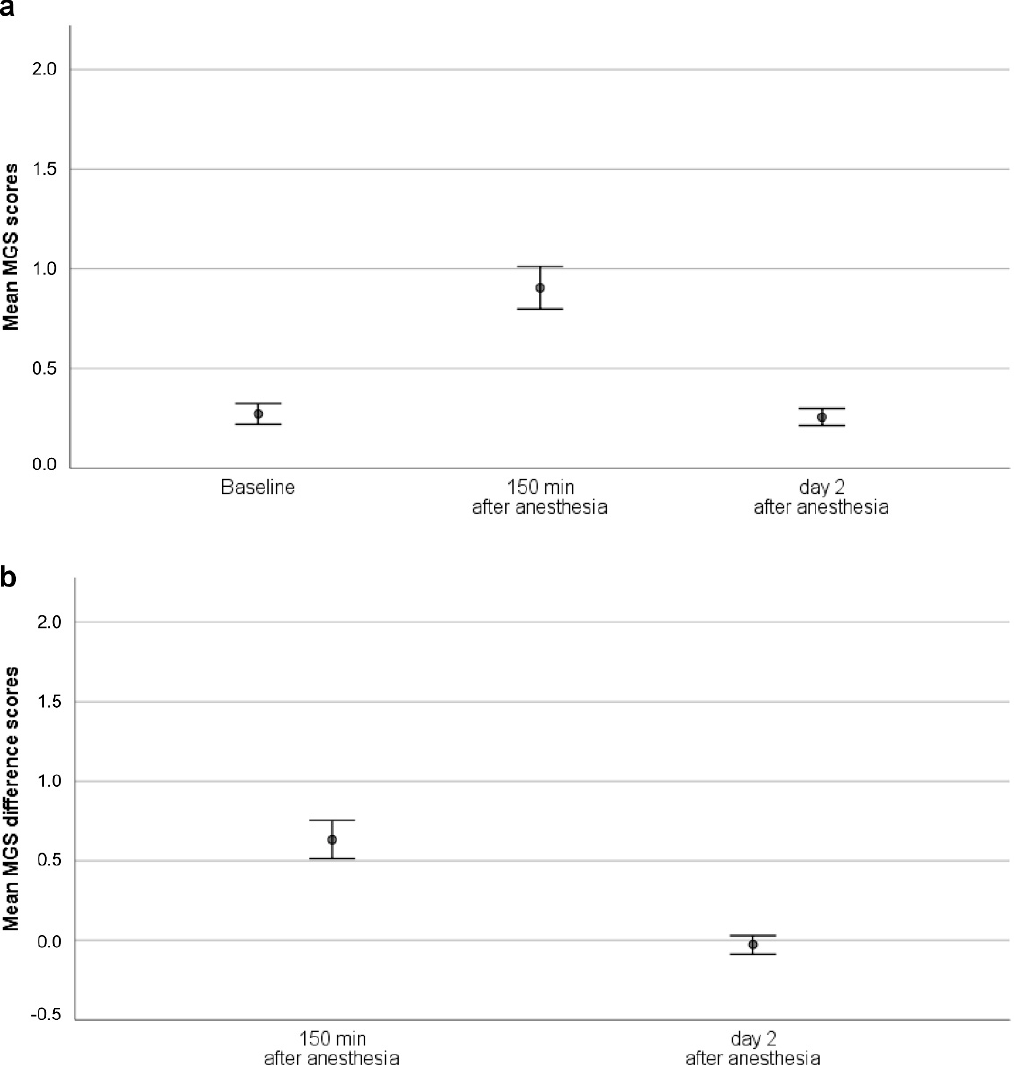
Table 1. Interrater reliability of overall MGS scores.